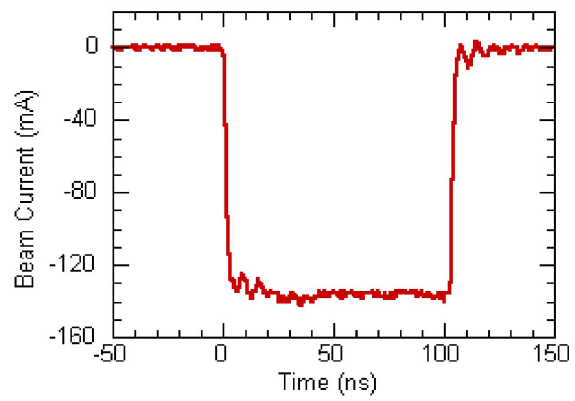
FIG. 4. (Color) Beam current signal measured by Bergoz coil.